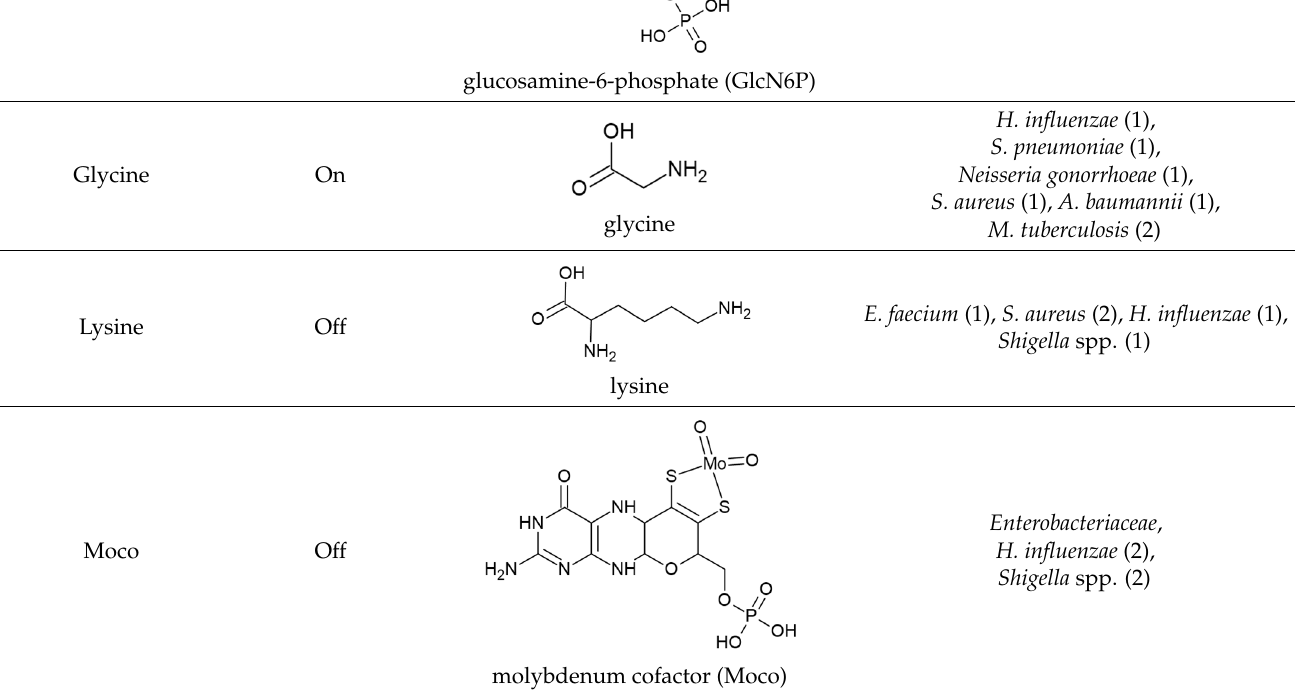
Table 1. Prevalence of riboswitches in WHO priority list pathogens. The prevalence of each riboswitch among the WHO priority list pathogens was obtained from the Rfam database [24] using the riboswitch class and bacterial species as query key words and is listed in brackets. The number in brackets represents the range of riboswitch abundance in different strains of bacterial species.